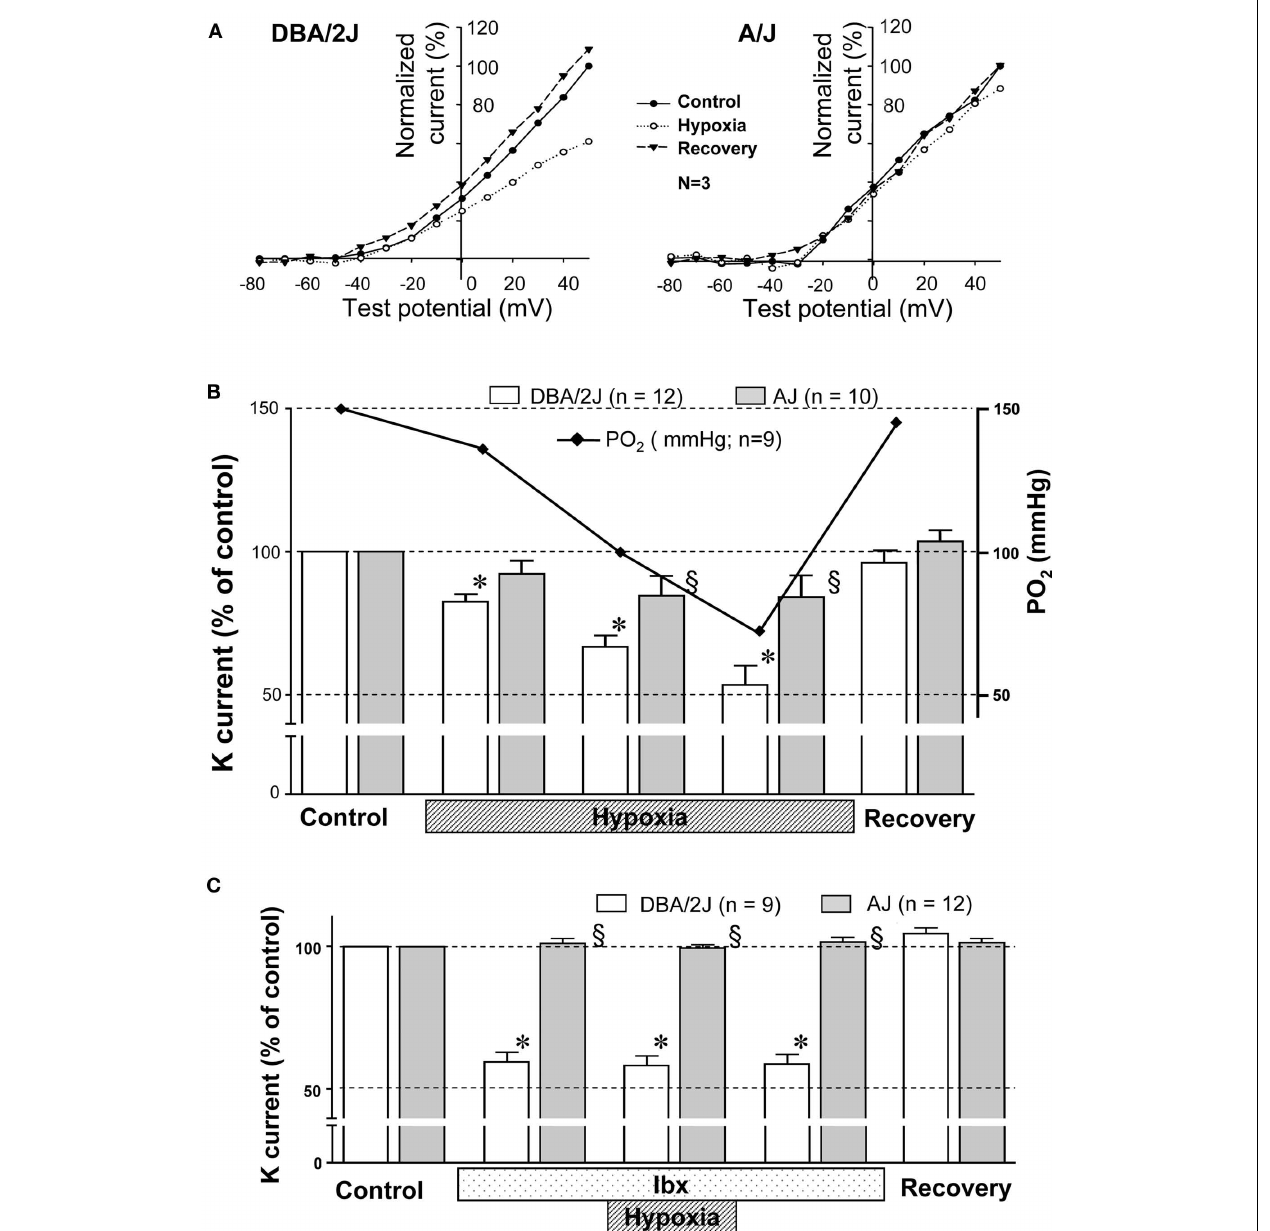
FIGURE 4 | (A) The effect of decreasing O 2 on voltage-dependent outward K current in GCs of the DBA/2J (left) and the A/J mice (right).Whole current was evoked by voltage steps from − 80 to + 50mV with 10mV increments for 100ms.To construct a current–voltage curve, the mean current measured between 93 and 97ms from the start of each voltage step was plotted versus the test pulse.The current during hypoxia was recorded after 5–10min of superfusion with hypoxic Krebs solution. Each current was normalized as % of the current measured at + 50mV of test pulse during normoxia. I – V curves were mean values obtained from three GCs in each strain. (B) During control, the CB was superfused with Krebs equilibrated with 5% CO 2